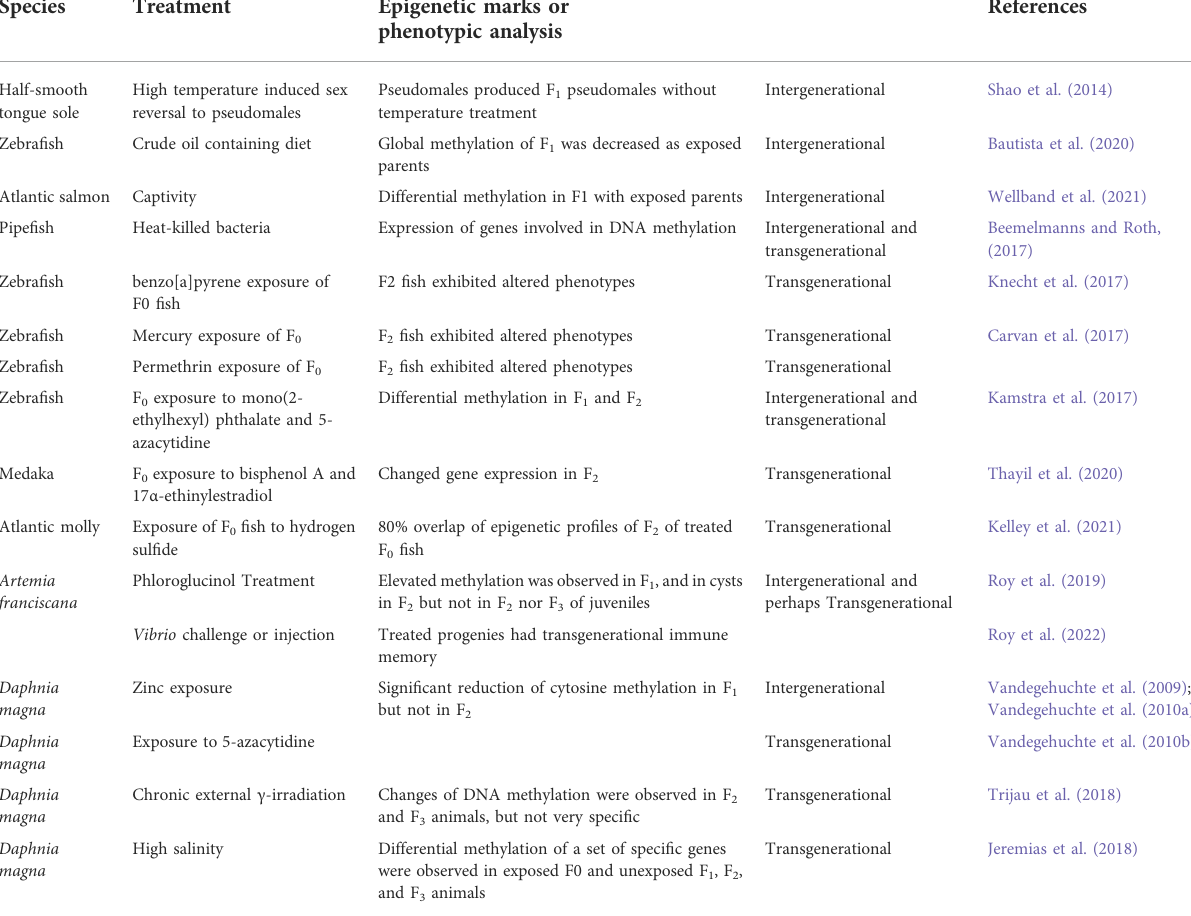
TABLE 8 Examples of studies of intergenerational and transgenerational epigenetic inheritance.